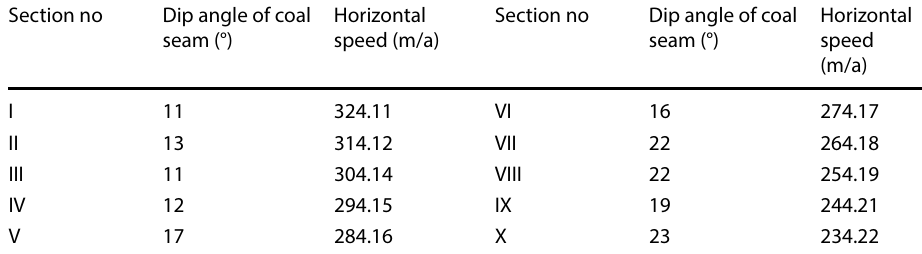
Table 5 Linear fitted horizontal advancing speed of working